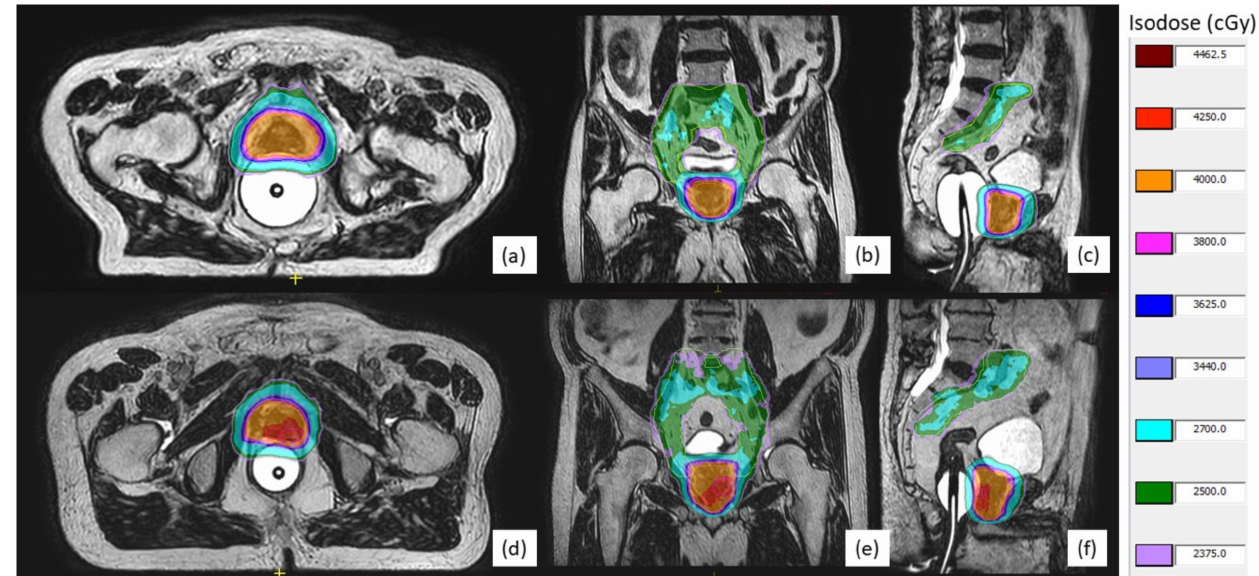
Figure 1. Examples of magnetic resonance-guided stereotactic body radiotherapy plan on high-risk prostate cancer patients without ( a – c ) and with ( d – f ) dominant intraprostatic lesions (DILs). PTV, PTV_L, and DILs are indicated by orange, green, magenta, and red solid lines, respectively. Isodose levels are also illustrated by different